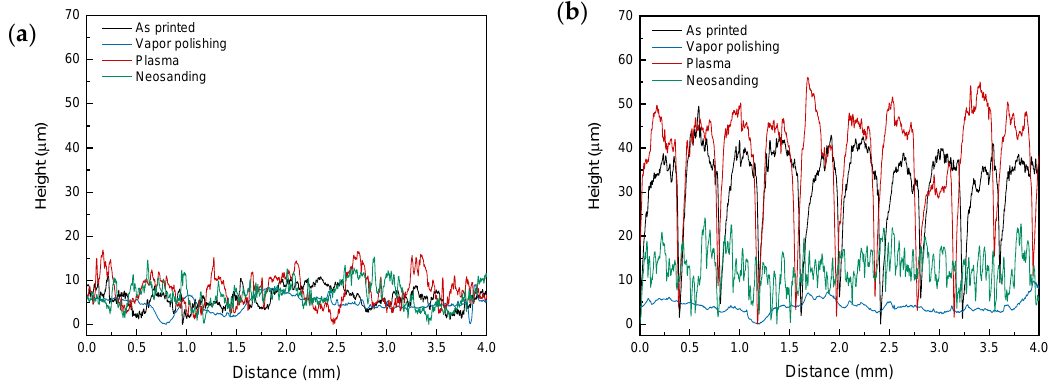
Figure 9. Surface profiles of as printed and surface post processed parts: ( a ) X - and ( b ) Y - profiles.